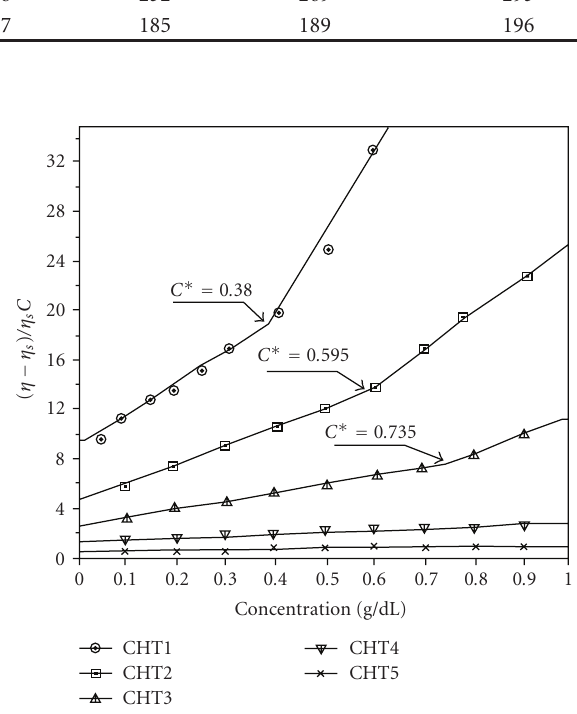
Figure 4: Intrinsic viscosities of di ff erent grades of